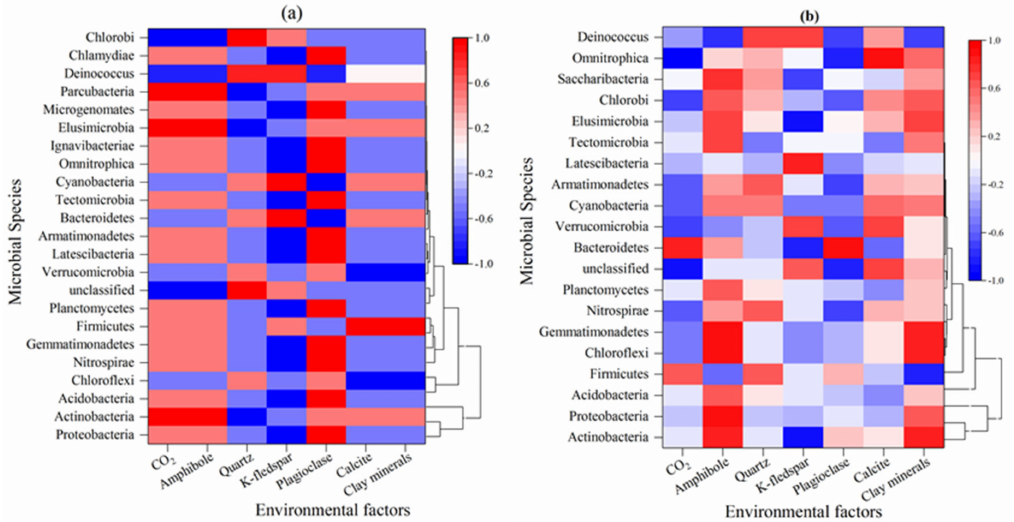
Figure 10. Heatmap of Spearman’s correlation coe ffi cients between bacterial community species (phylum) in soil and environmental factors (( a ) is the vertical heatmap of W01–W03, and ( b ) is the horizontal heatmap of